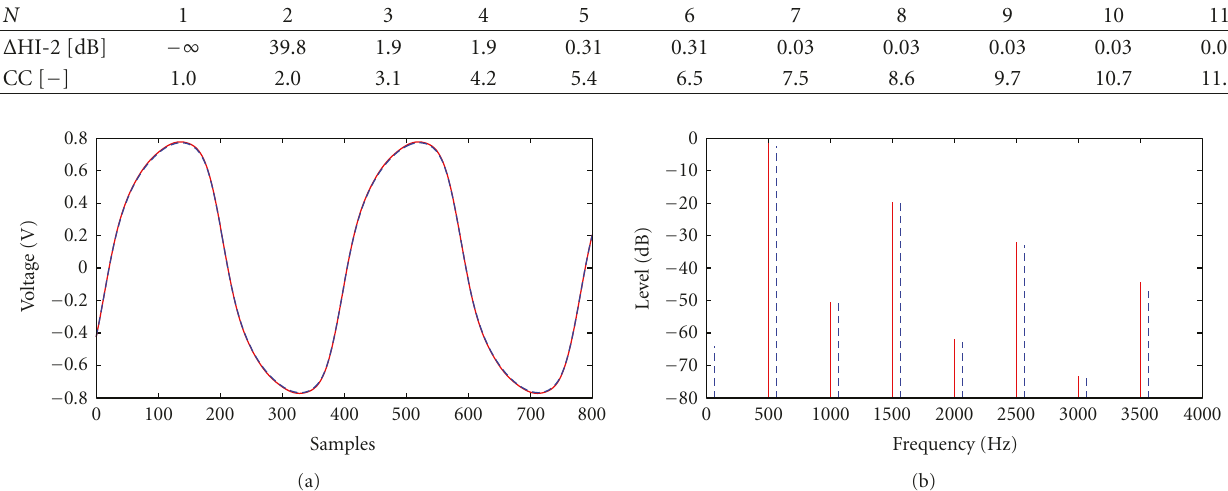
Figure 5: Comparison between the real-world output of pedal 1 (blue-dashed) and the GPH model-based output (red-solid) in time (a) and frequency (b) domains, for a sine wave excitation with f 0 = 500 Hz and A 0 = 1 V. The GPH model is estimated using a swept sine signal with amplitude A s = 1V. For the sake of clarity, the output of the real-world device in the frequency domain is shifted to the right.